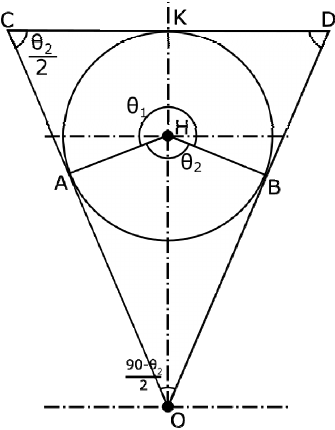
Figure 2. Geometric representation of the quick return